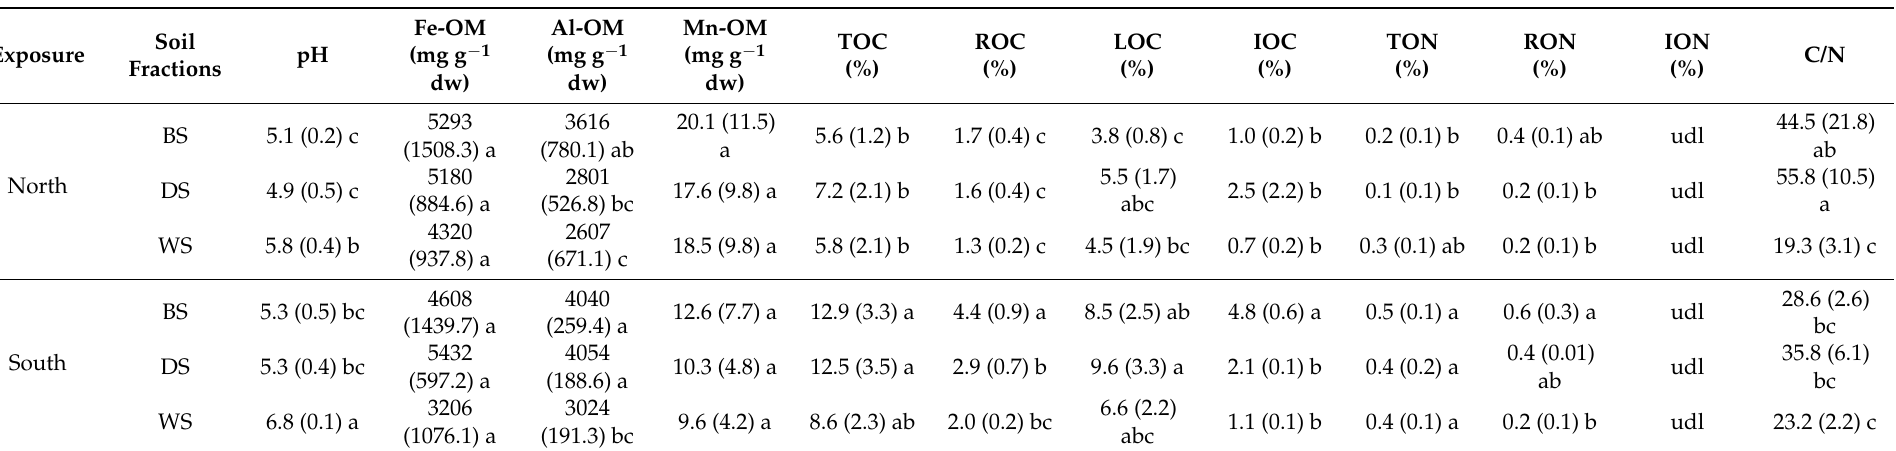
Table 4. Overview of the physico-chemical properties observed in the bulk soil and the aggregate size fractions (dry-sieved and water-stable 1.00–0.50 mm) in the mineral (AE) horizon at the north- and the south-facing sites. Values are means ( n = 3) with the standard deviations in brackets. Data are expressed on a dry weight basis. In each column, different letters indicate significant differences ( p < 0.05 according to Duncan post-hoc test) among the soil fractions (bulk soil [BS],